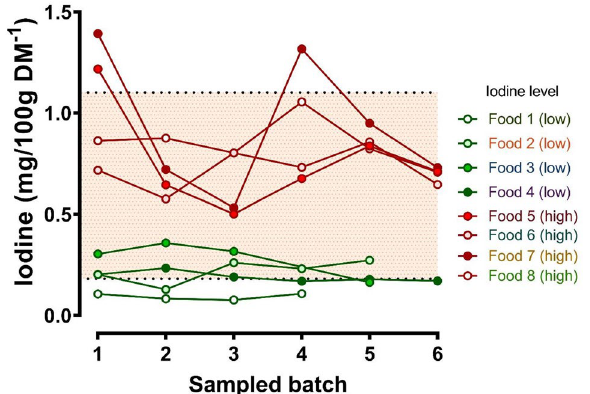
Figure 3. Batch-to-batch variation in iodine content of complete wet feed for pet cats. Iodine was measured by ICP-MS in duplicate samples (100–200 mg) of the freeze-dried, homogenised, TMAH-digested foods and corrected to the iodine concentration measured in duplicate TMAH-digested blank samples and certified reference material (CRM; SERO210705 Seronorm Trace Elements Urine L-2; LGC Standards). Dashed lines show the legal maximum and recommended minimum level of iodine that complete foods for adult cats should contain, according to